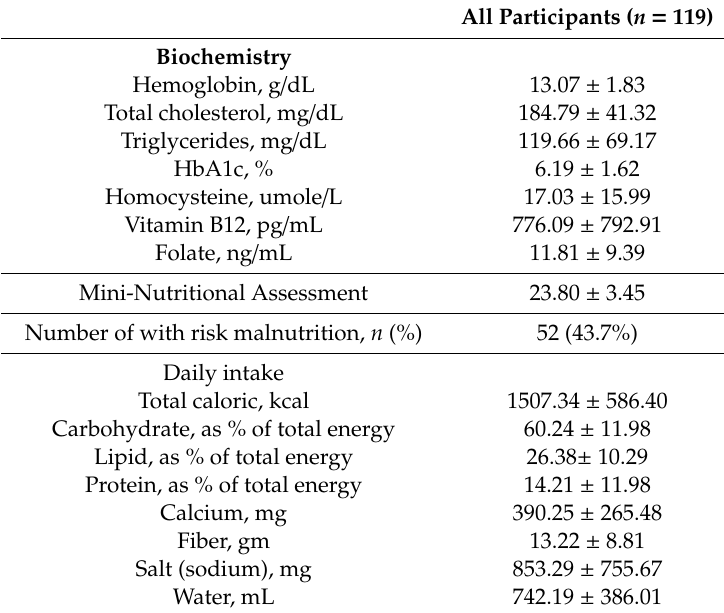
Table 2. Biochemical characteristics and daily intake of patients with